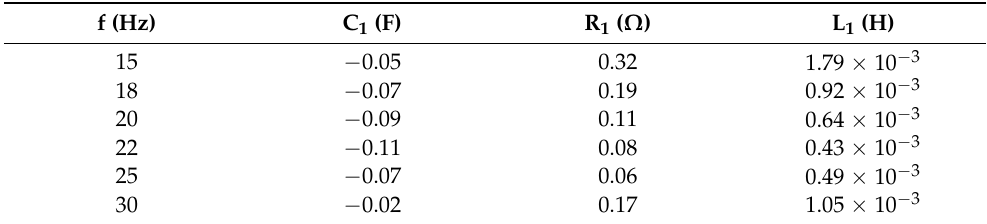
Table 5. Inductance, capacitance, and resistance of the bimorph piezoelectric harvester resulting from the experimentally measured mechanical